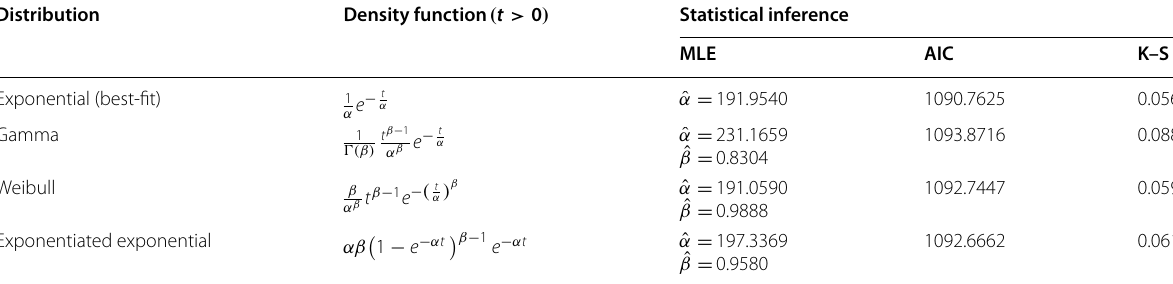
Table 1 Probability distributions and results of statistical inference of natural